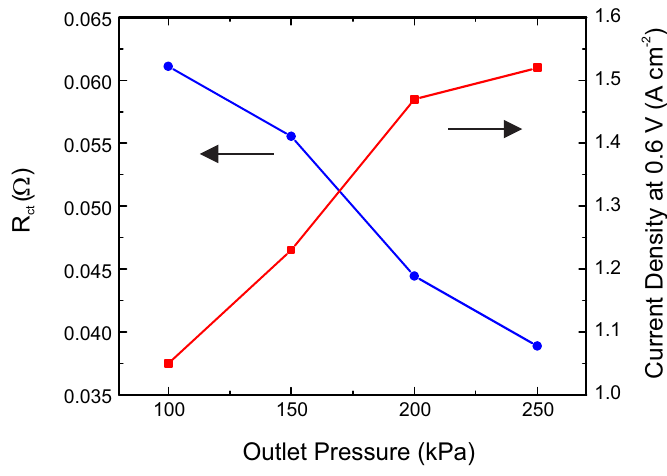
Figure 7. Current density at a cell voltage of 0.6 V and charge transfer resistance at a cell voltage of 0.8 V as functions of outlet